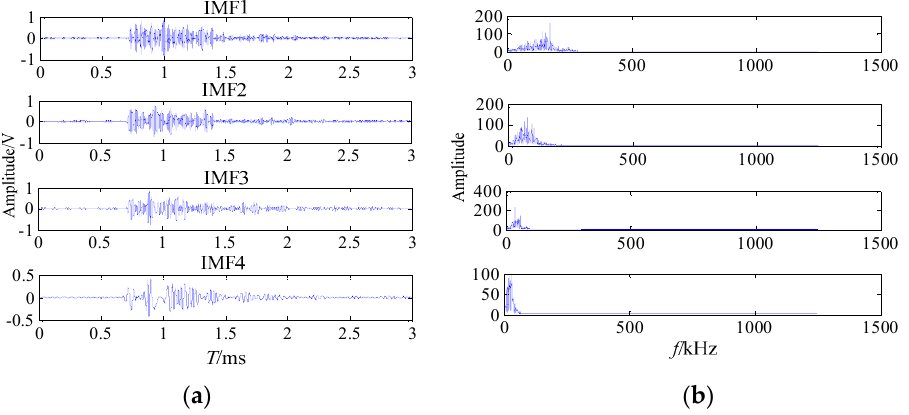
Figure 13. The waveforms and spectra of the first four IMFs ( a ) the waveform; ( b ) the frequency